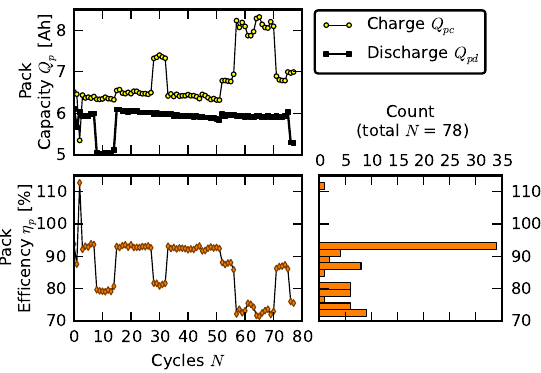
Figure 12. Coulombic efficiency of a pack during cycling (Scenario